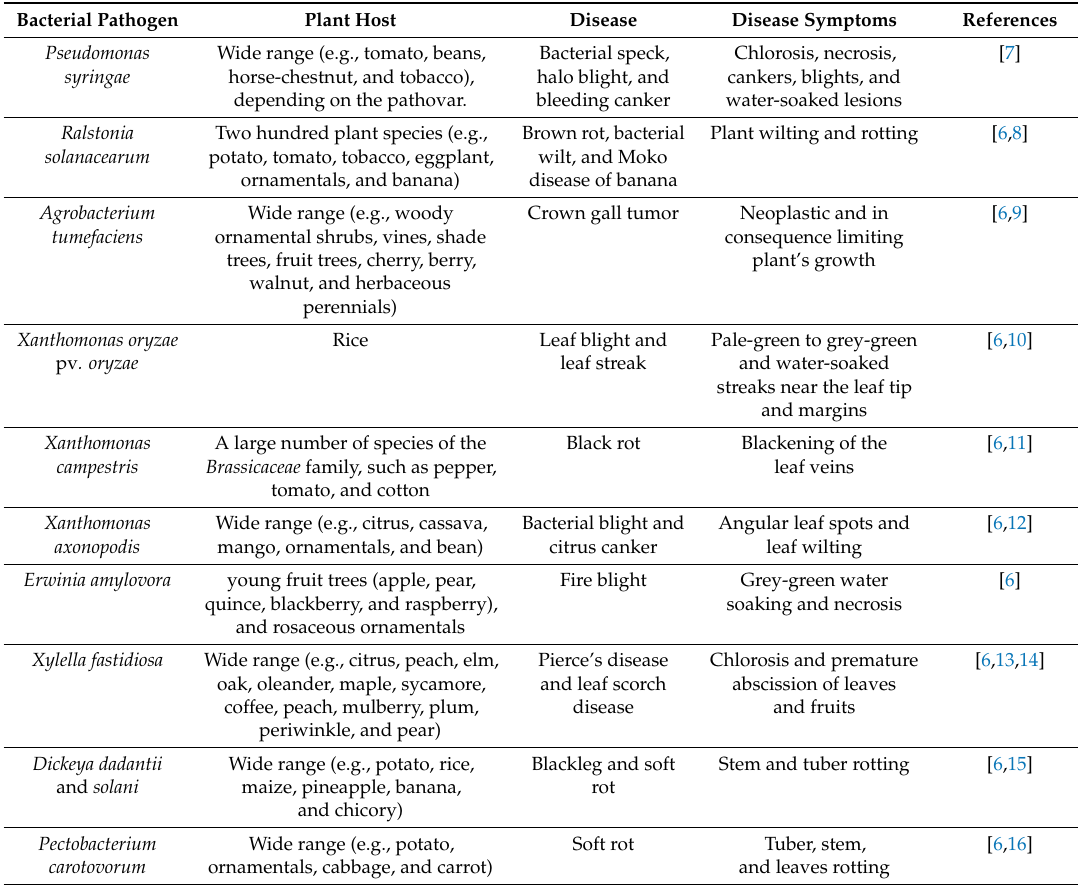
Table 1. Characteristic of selected plant pathogenic